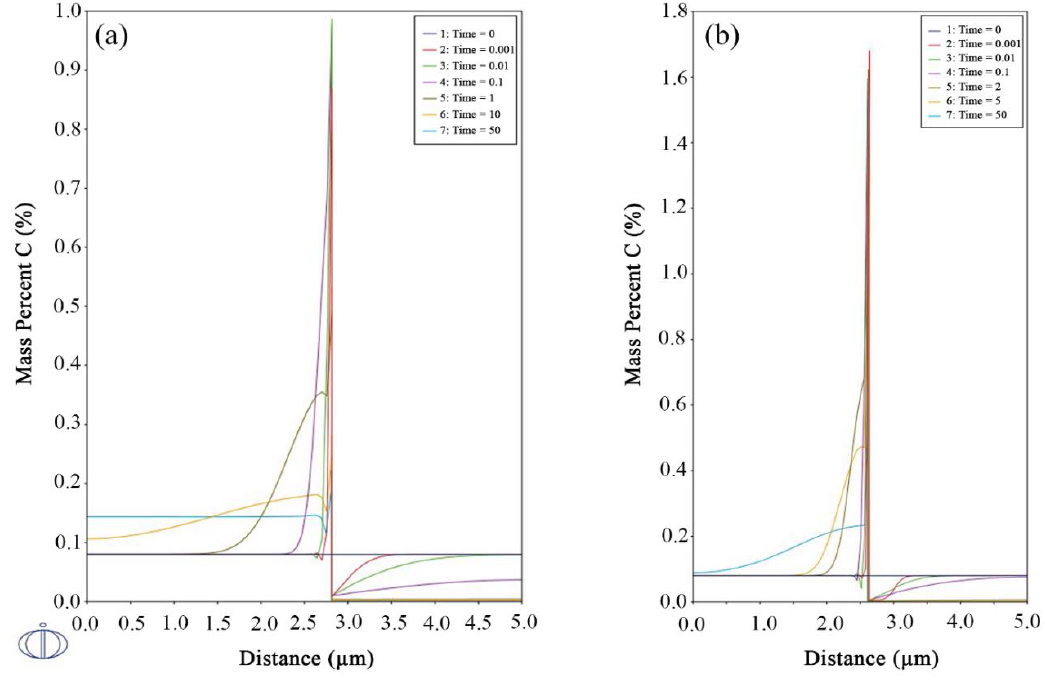
Figure 5. Carbon content of ( a ) Fe – 0.08 wt % C – 1.78 wt % Mn system at 640 °C; ( b ) Fe – 0.08 wt % C – 1.78 wt % Mn system at 540 °C.